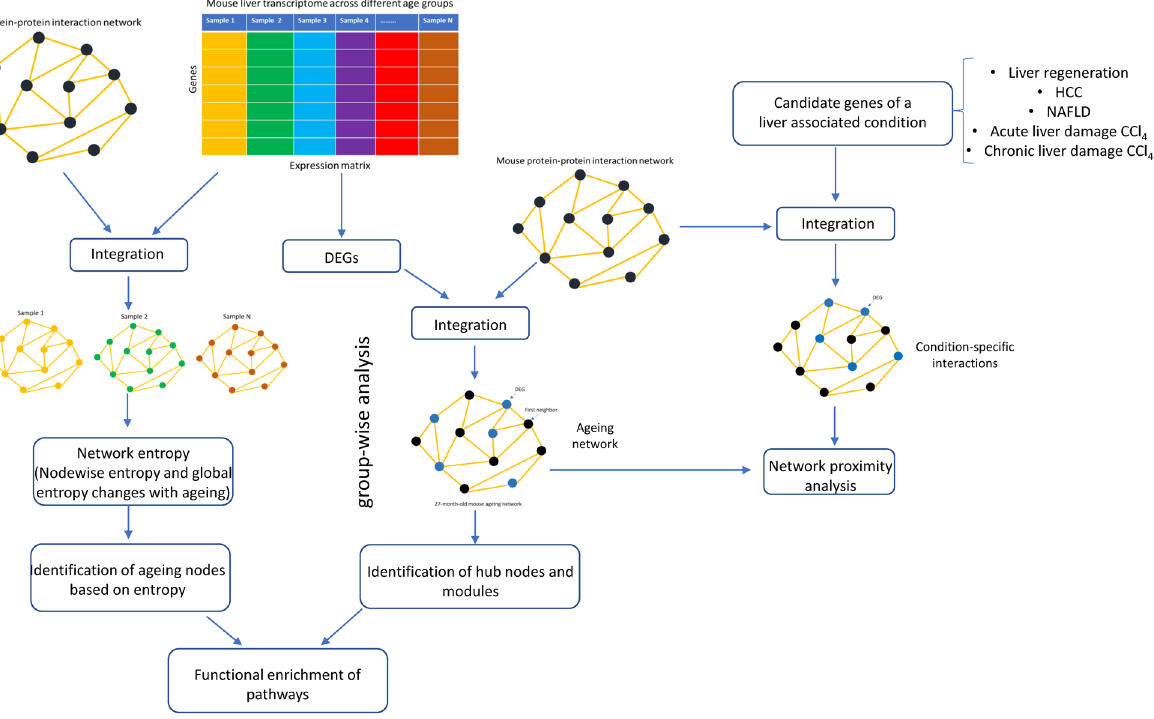
Figure 1. The workflow to study the network-level changes of ageing and its association with tissue regeneration and diseases in the mouse